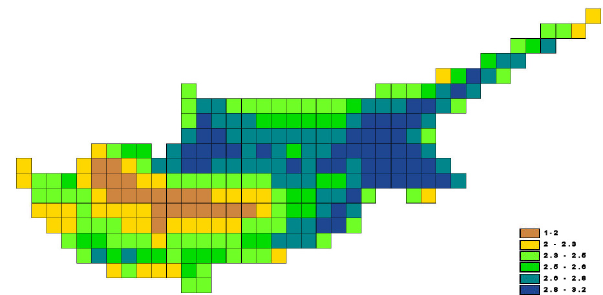
Fig. 6. The spatial distribution of AVHHR derived PW values esti- mated at each grid cell by averaging the daily values for July